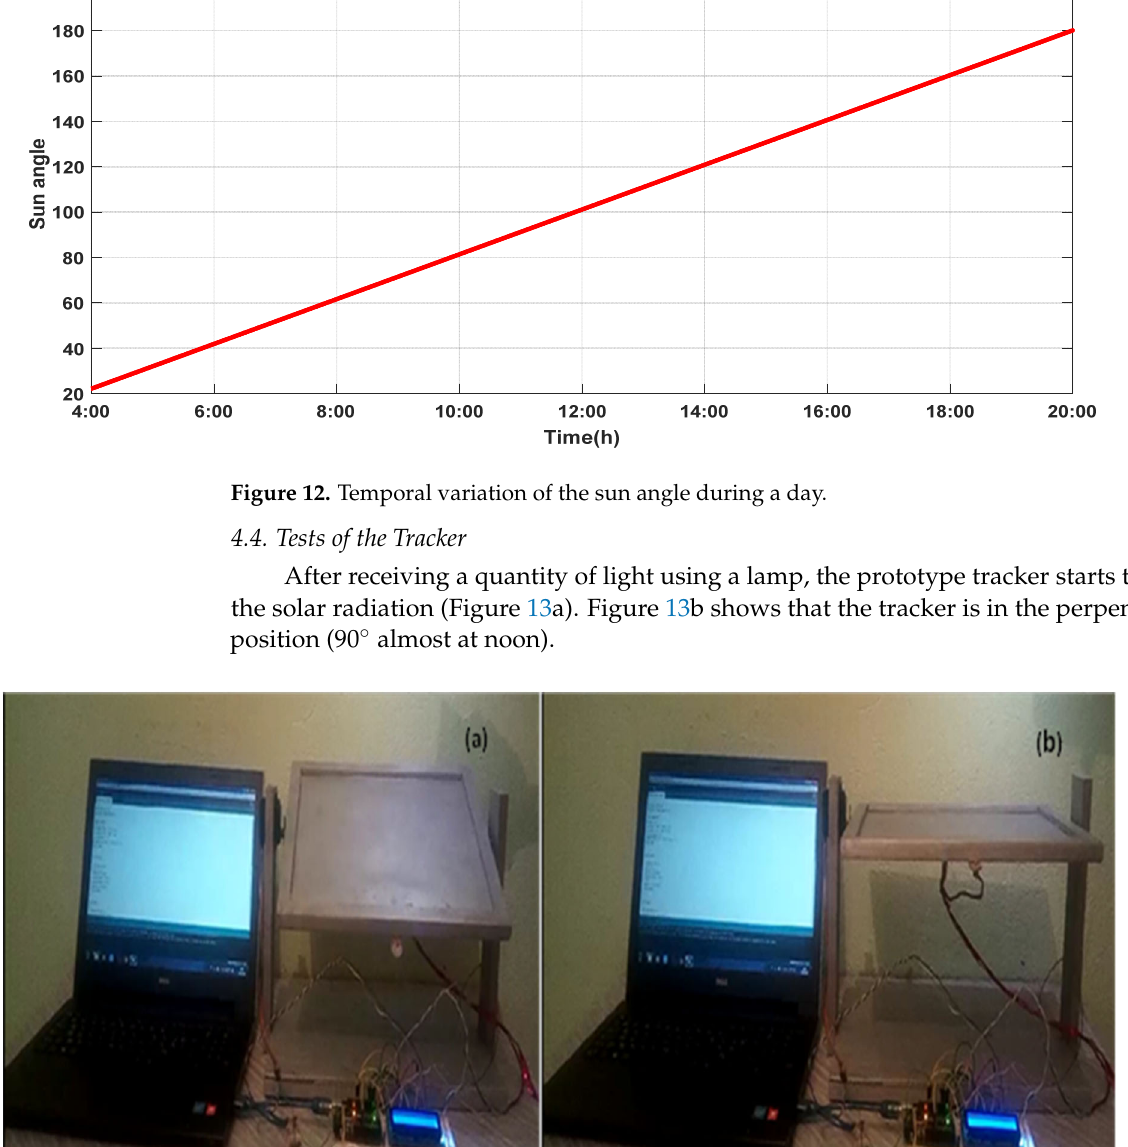
Figure 13. Tests of the tracker position: ( a ) start position of the solar tracker realized to start track ‐ ing of the light. ( b ) Perpendicular position (90°) of the solar tracker.